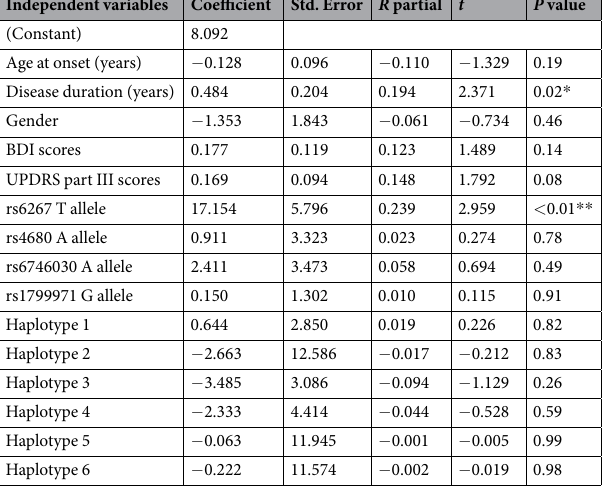
Table 3. Multiple linear regression analysis of factors correlated with pain severity assessed using King’s PD pain scale in patients with PD with pain (n = 193). In this model, the presence of pain in PD patients was set as the dependent variable and the onset age of PD motor symptoms, disease duration, sex, BDI scores, UPDRS part III scores in the on state of PD, and minor allele frequency of pain-related candidate genes in this study were set as independent variables (R 2 = 0.154 and P = 0.005). R: correlation coefficient based on the model of multiple linear regression; t : t value for the coefficient of each parameter in the model; p : for R or t . BDI, Beck Depression Inventory; UPDRS, Unified PD rating scale. The sequence of alleles in each haplotype for central haploblock of COMT gene reflects the order of occurrence from 5 ′ to 3 ′ in the COMT gene (SNPs: rs6269, rs4633, rs4818 and rs4680, respectively). Six haplotypes out of possible 16 were detected from these four SNPs with the most frequent haplotype (Haplotype 1, 24.6%) composed of the most frequent alleles for SNPs rs4633 and rs4680 and the least frequent alleles for SNPs rs6269 and rs4818 (G_C_G_G for SNPs rs6269, rs4633, rs4818 and rs4680, respectively). The second major haplotype (Haplotype 2, 24.3%) was composed of the most frequent alleles for SNPs rs6269 and rs4818 and the least frequent alleles for SNPs rs4633 and rs4680 (A_T_C_A). The third haplotype (Haplotype 3, 16.1%) was composed of a combination of the most frequent alleles for all SNPs (A_C_C_G). The fourth major haplotype (Haplotype 4, 14.3%) composed of the least frequent alleles for all markers (G_T_G_A). The fifth major haplotype (Haplotype 5, 11.9%) composed of the described alleles of the four markers (A_C_G_G) and the sixth haploptye (Haplotype 6, 1.1%) composed of the described alleles of the four markers (G_C_C_G). These six haplotypes accounted for 92.3% of all detected haplotypes in our studied